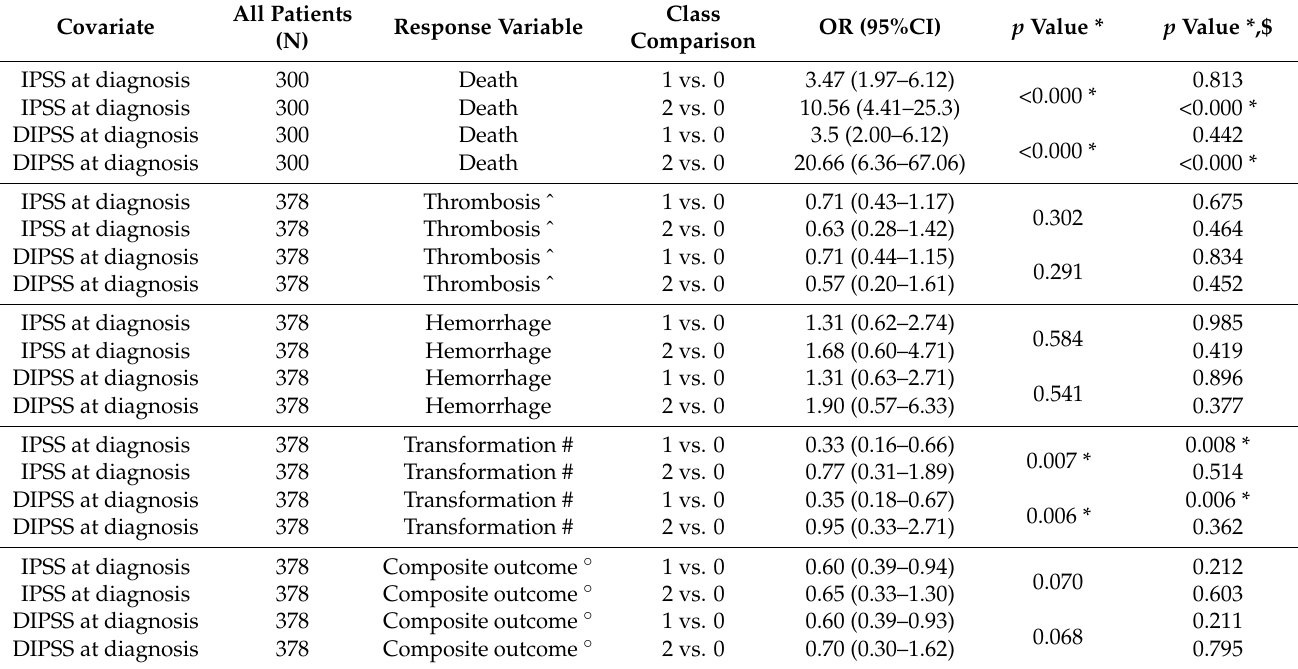
Table 2. Univariable analysis considering the association between IPSS or DIPSS at diagnosis and all possible